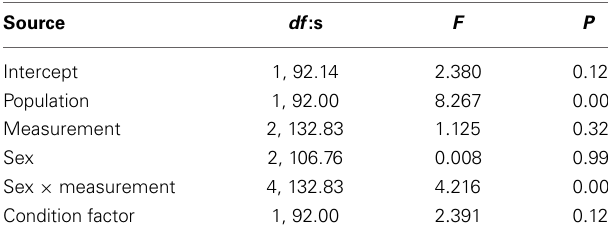
Table 3 | Significance of fixed factors in explaining variance in activity score according to linear mixed effect model.